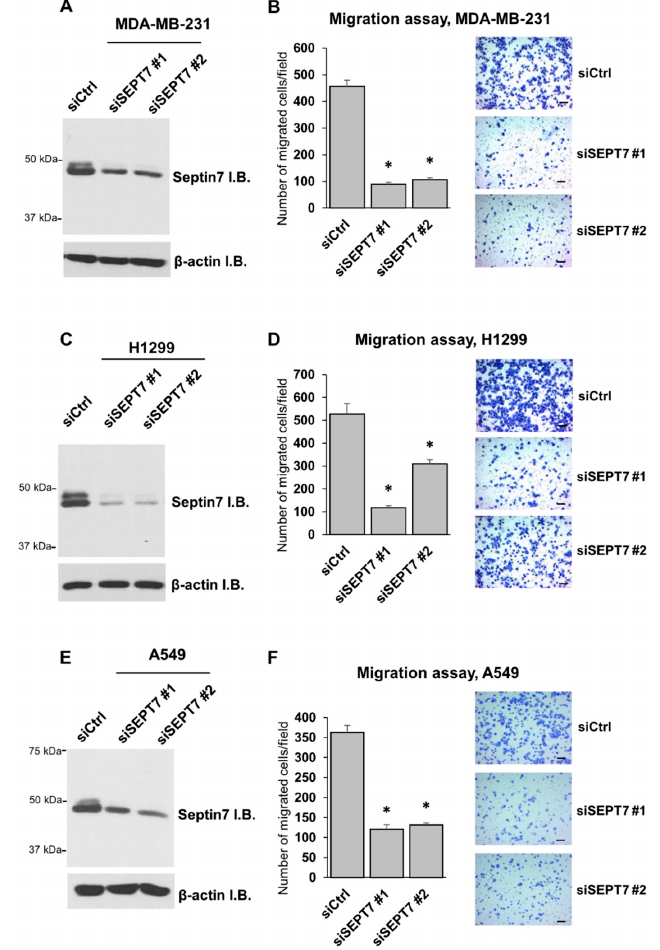
Figure 5. Knockdown of septin 7 decreases cancer cell migration. ( A ) MDA-MB-231 breast cancer cells were transfected with 30 nM non-targeting siRNA (siCtrl) or siRNAs targeting septin 7: siSEPT7 #1 or siSEPT7 #2. Two days post-transfection, the cells were harvested and the knockdown was confirmed by Western blotting using an anti-Septin 7 antibody. ( B ) The migration ability of MDA-MB-231 with knockdown of septin 7 was determined by transwell migration assay. Values in the bar graphs represent mean ± SE ( n = 6 fields). *: significantly different compared to siCtrl ( p < 0.0001) by one-way ANOVA. Representative images of migrated cells stained with crystal violet are shown. Scale bar, 100 μ m. ( C ) Western blotting analysis of septin 7 protein level in H1299 lung cancer cells transfected with 30 nM of the indicated siRNA for two days. ( D ) Transwell migration assay for H1299 cells with knockdown of septin 7. Values in the bar graphs represent mean ± SE ( n = 6 fields). *: significantly different compared to siCtrl ( p < 0.001) by one-way ANOVA. Scale bar, 100 μ m. ( E ) Western blotting analysis of septin 7 protein level in A549 lung cancer cells transfected with 30 nM of the indicated siRNA for two days. ( F ) Transwell migration assay for A549 cells with knockdown of septin 7. Values in the bar graphs represent mean ± SE ( n = 6 fields). *: significantly di ff erent compared to siCtrl ( p < 0.0001) by one-way ANOVA. Scale bar, 100 µ